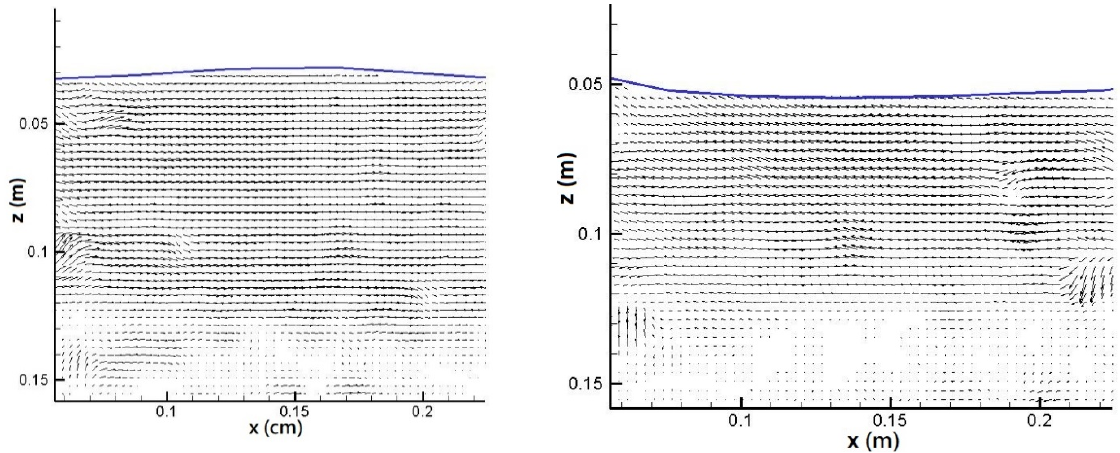
Figure 18. Velocity distribution of a long-period wave ( T = 2.0 s) around vegetation region ( ϕ = 0.5 cm and d = 5 cm).